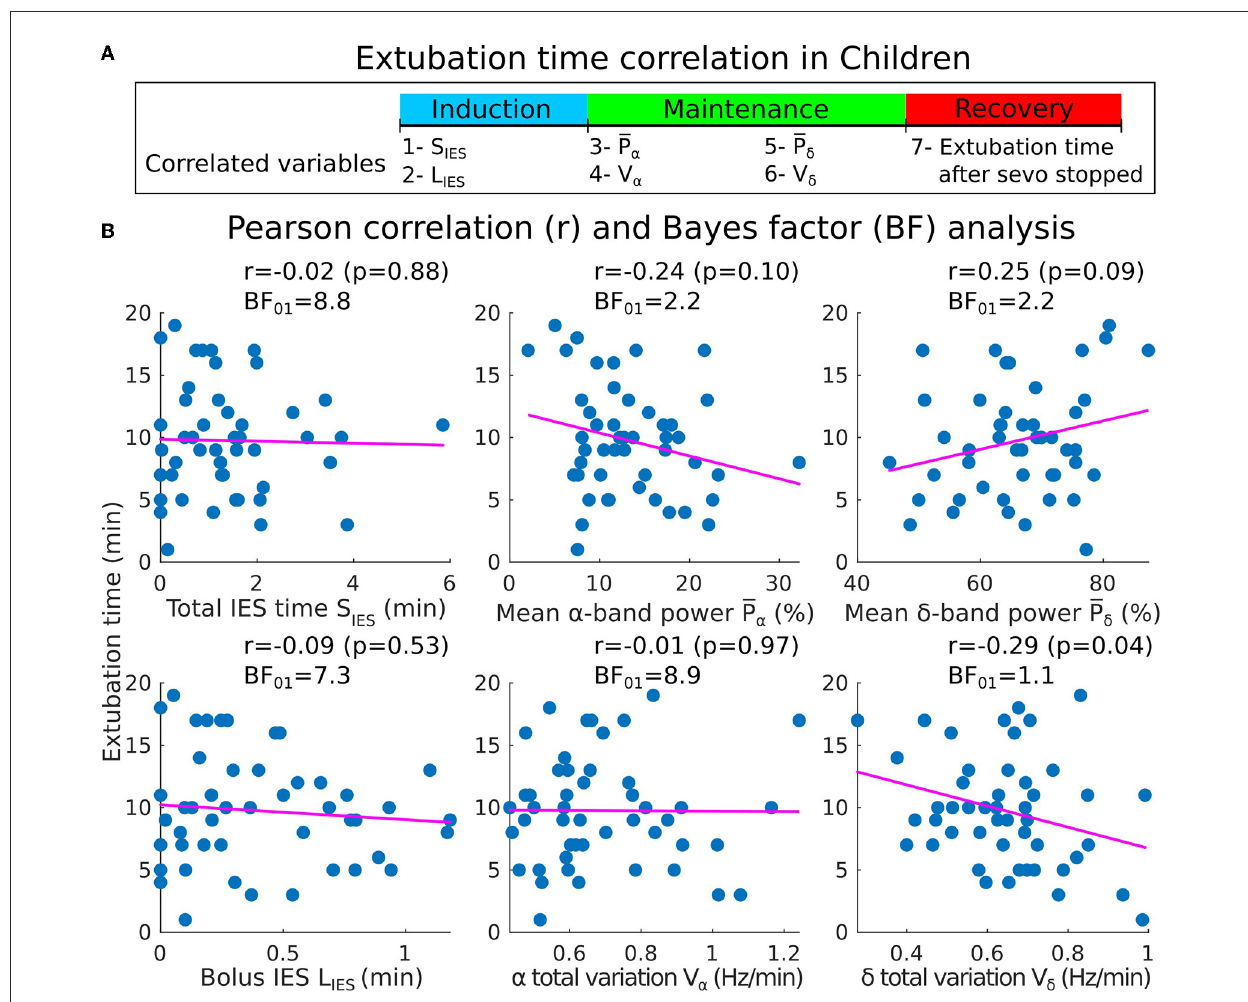
FIGURE7 Pearson correlations between the induction/maintenance phases and the extubation time after the sevoflurane has stopped (children cohort). (A) Extubation time after the administration of sevoflurane has stopped vs. S IES , L IES , P α and V α collected during induction and maintenance. (B) Scatter plots and Pearson correlations (coefficient r , p -value p ) between the extubation time and S IES , L IES (first column), P α , V α (second column), P δ and V δ (third